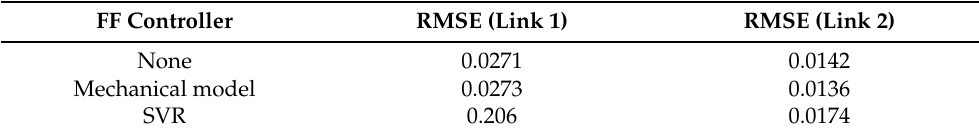
Table 4. RMSE results.